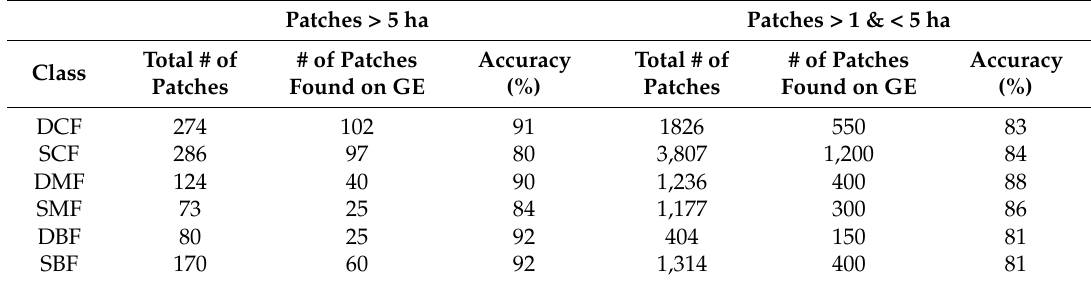
Table 6. Validation summary of deforestation/degradation patches between 2000–2010 using Google Earth (GE) images.